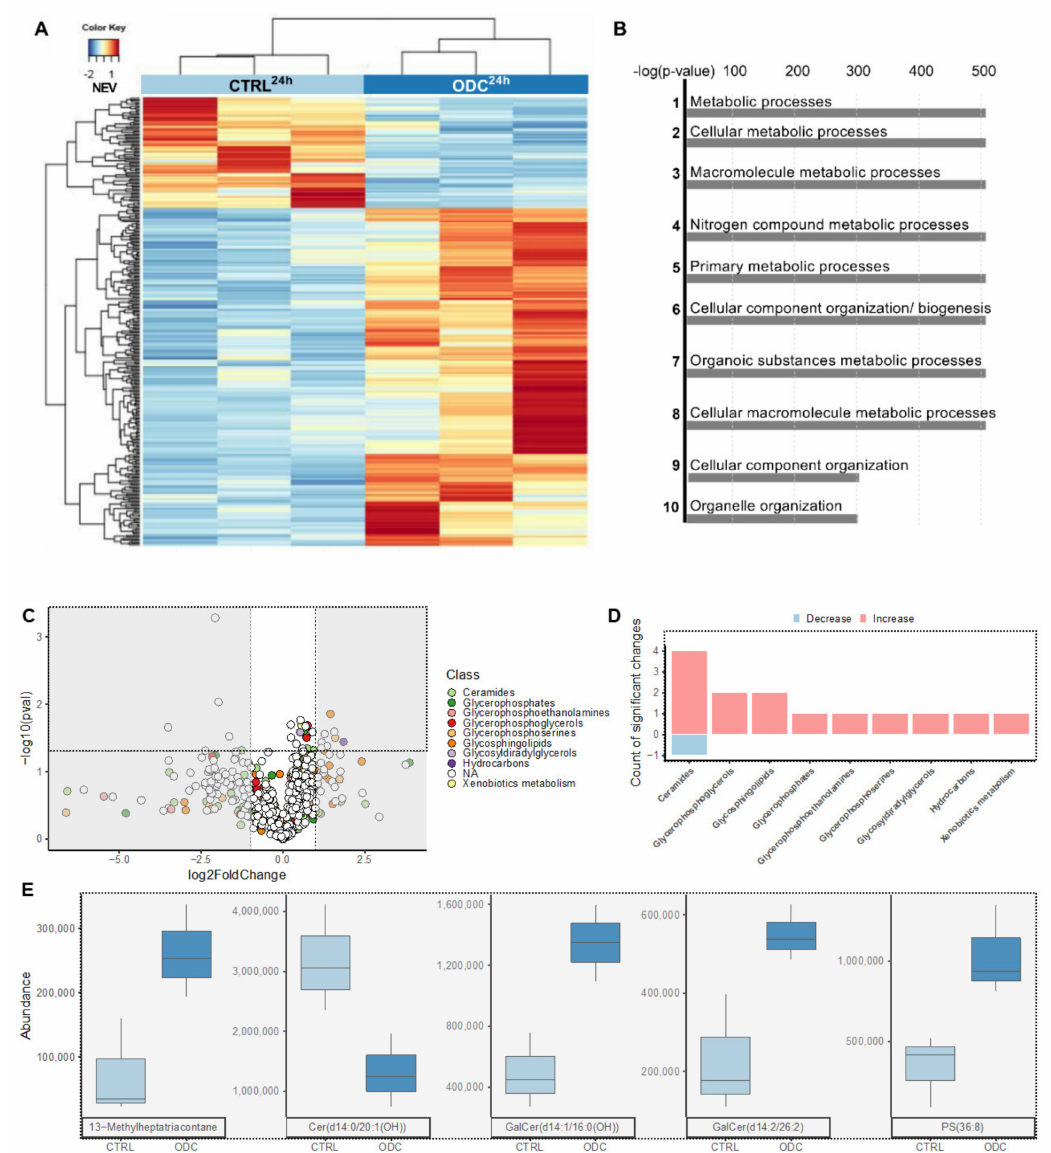
Figure 2. RNA sequencing and LC-HRMS/MS metabolomics analysis of Caki-1 cells treated or not with ODC REMP . ( A ) Heat map representing the significant differential expression of 93 genes, comparing sham-treated Caki-1-SR (CTRL) and ODC REMP -treated Caki-1-SR cells (REMP). The treatments were applied for 24 h before the analysis. The normalized expression value (NEV) is represented by a color scale, with blue for a low expression and red for a higher expression value. ( B ) Pathway enrichment analysis showing that the gene ontology terms correspond to significant alterations in metabolic processes. The top 10 significantly dysregulated pathways are listed. ( C ) Volcano plot of the 624 features (m/z at retention time) obtained after metabolomics treatment of the LC-MS data in positive mode (Figure S14 and Table S9). Dots are colored according to the annotated chemical class. Dots included in the light grey rectangles represent an absolute log (fold change) higher than 1. Dots included in the black dashed rectangle represent significant changes ( p < 0.05) and are detailed in ( D ), classes with significant changes. The class with highest number of significant changes (four increased and one decreased) was ceramide, with other significantly increased phospholipids classes. ( E ) Normalized peak areas of the five annotated features both significantly increased or decreased with an absolute log (fold change) higher than 1 (present in black dotted and grey rectangles). Features were labelled according to RefMet [76]. An overview of all ceramides with either p < 0.05 or abs (log(fold change)) > 1 is given in Table